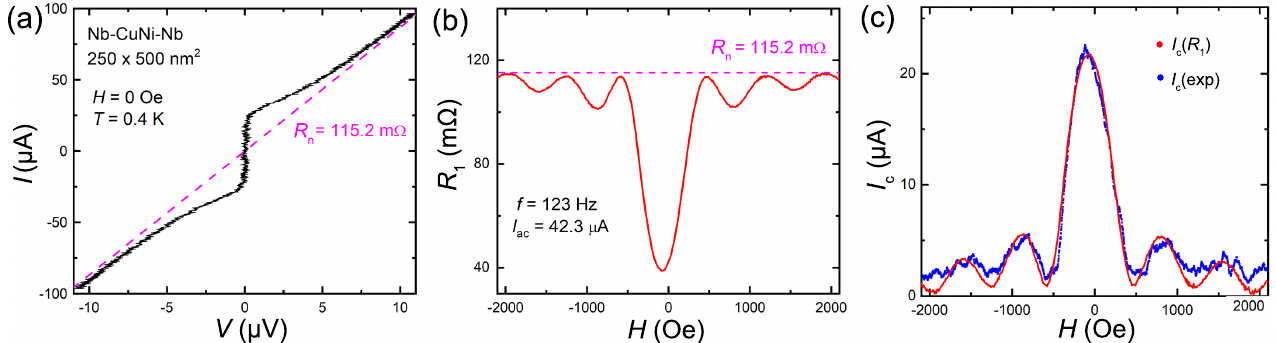
Figure 3. ( a ) The I – V characteristics of a Nb–CuNi–Nb junction at H = 0 and T (cid:39) 0.4 K. The dashed line indicates normal resistance R n = 115.2 m Ω . ( b ) Measured field dependence of the first harmonic lock-in resistance R 1 . The horizontal dashed line indicates the R n level. ( c ) Field modulation of the critical current, determined using I – V s (blue symbols), and recalculated with R 1 (red line) using Equation